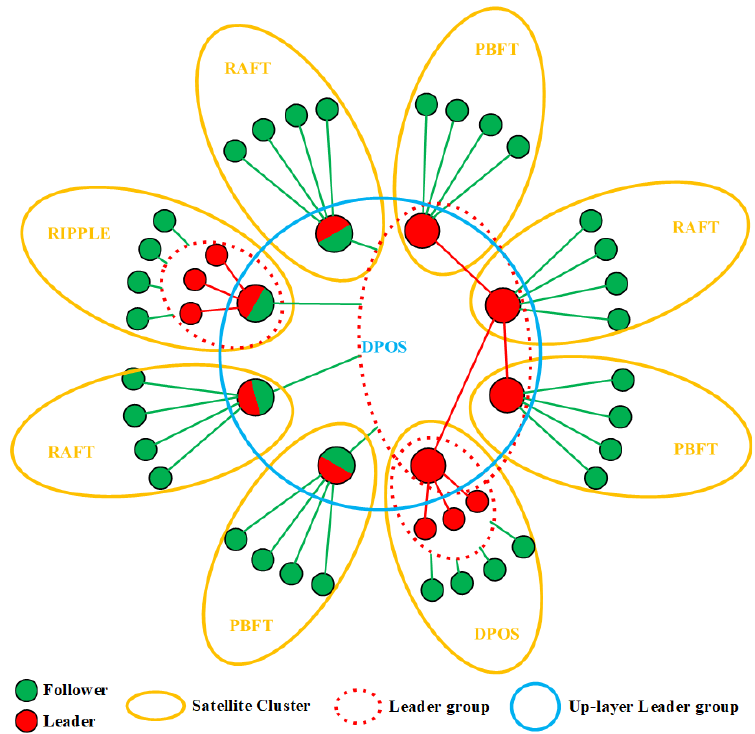
Figure 2. The structure diagram of the DDPOS